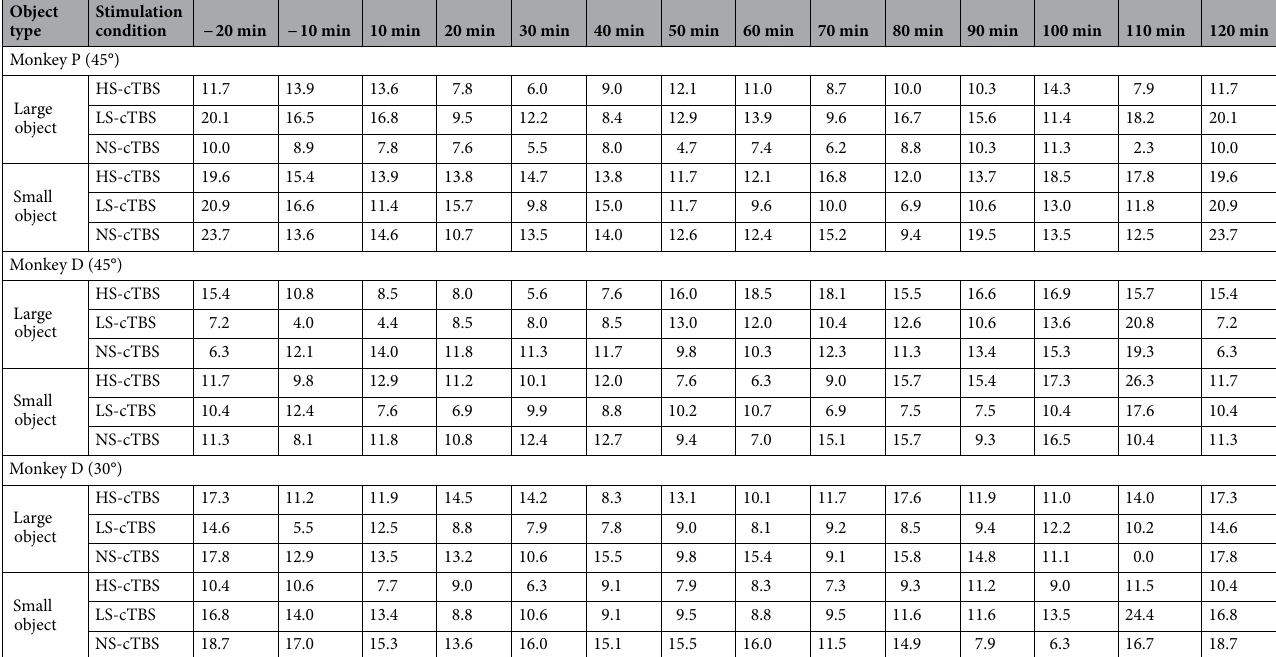
Table 3. Percentage of errors made with the large and small object for the high-, low- or no-intensity cTBS conditions (for each monkey, 45-degrees vs